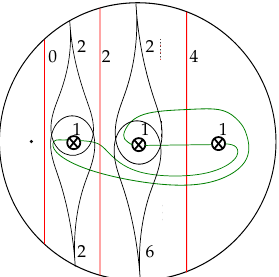
Figure 4. A curve